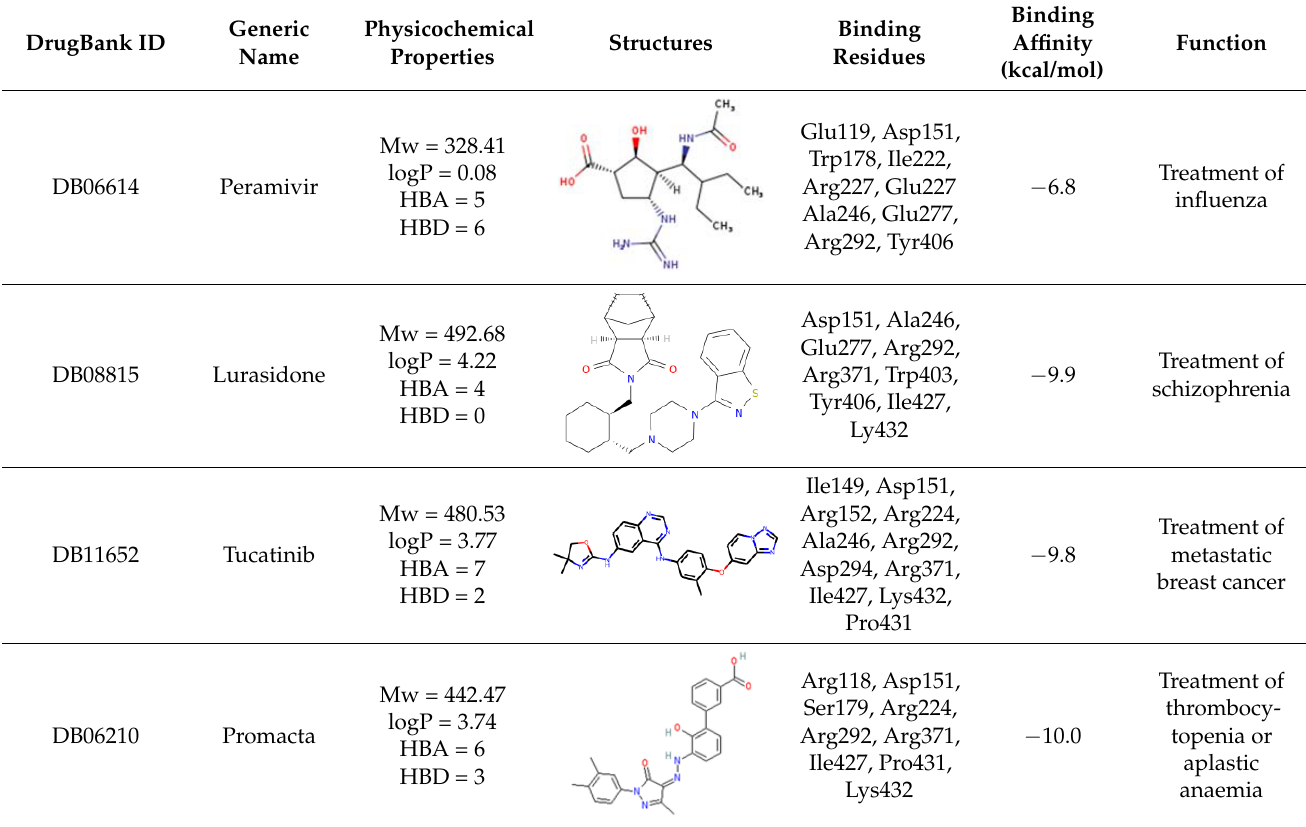
Table 1. Virtual screening results of the hit compounds.